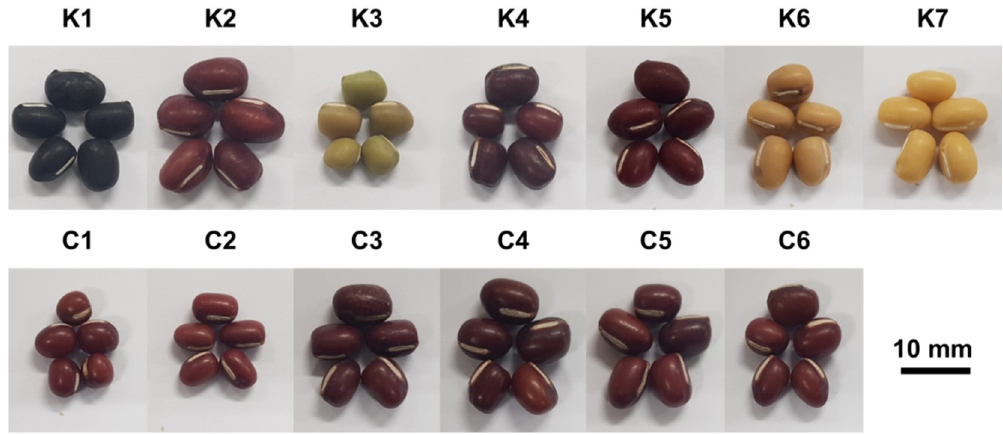
Figure 6. Variation in bean colour and shape among 13 adzuki bean phenotypes (K#, Korean sample number; C#, Chinese sample